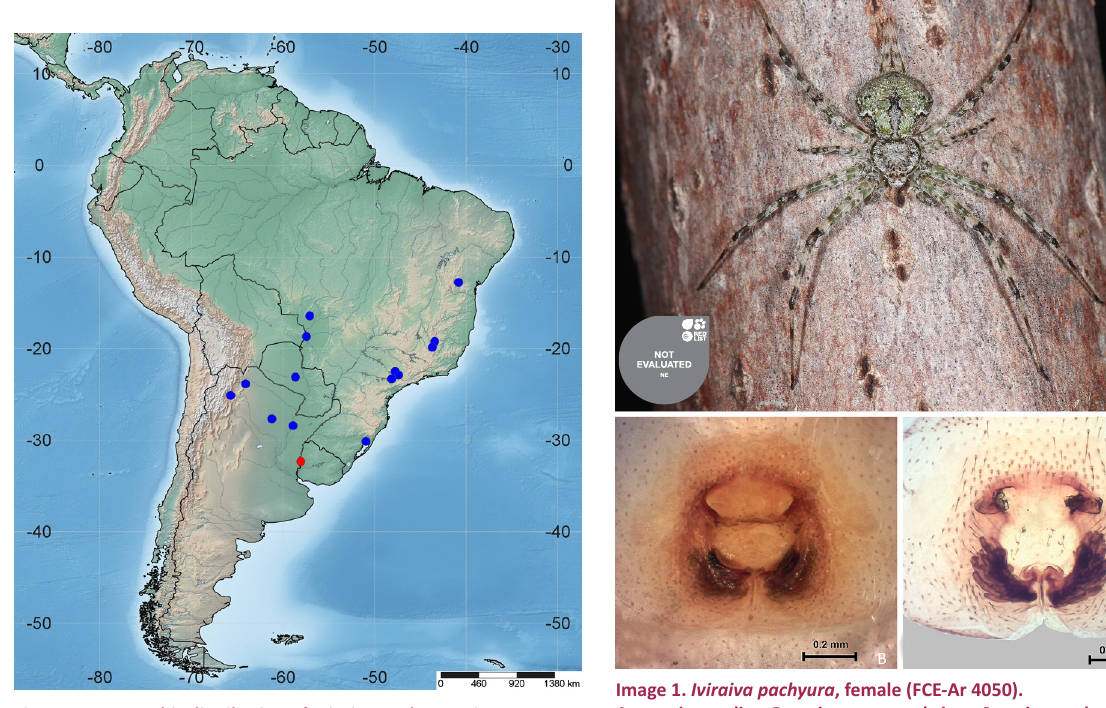
Figure 1. Geographic distribution of Iviraiva pachyura . Literature records: blue circle, new record: red circle.